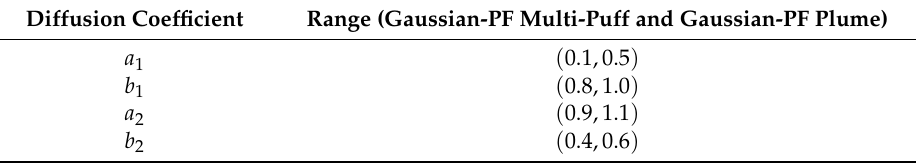
Table 2. Ranges of diffusion coefficients in Gaussian-PF